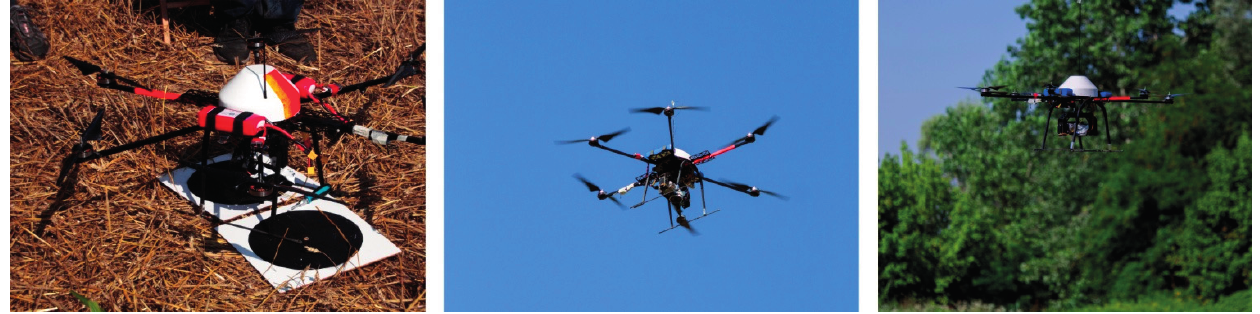
Figure 3. Hexakopter multi-rotor platform ( left ) and take-off and flying phases ( center and right